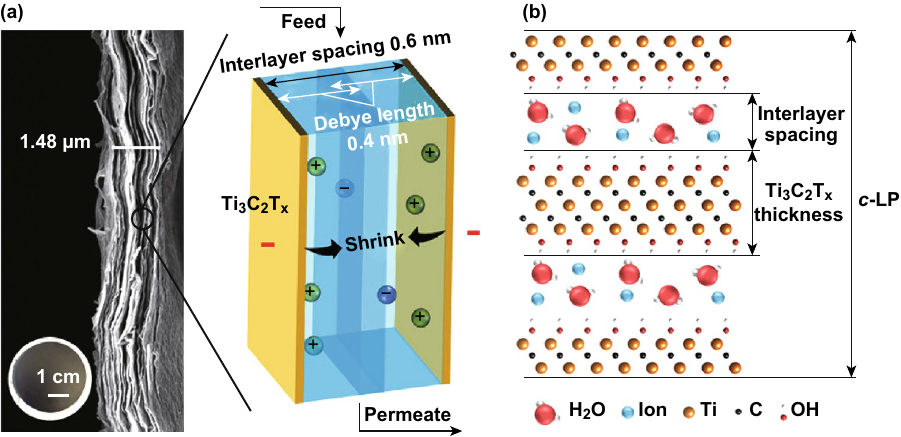
Fig. 9 a Cross-sectional SEM image of a Ti 3 C 2 T x membrane with a schematic showing the interaction between Ti 3 C 2 T x layers and ions within their EDLs when the Ti 3 C 2 T x membrane is connected to a negative voltage. b Molecular model of Ti 3 C 2 T x showing two layers of water with ions between the layers. The c lattice parameter ( c -LP) calculated from XRD is two Ti 3 C 2 T x flake thicknesses and two interlayer spacings.